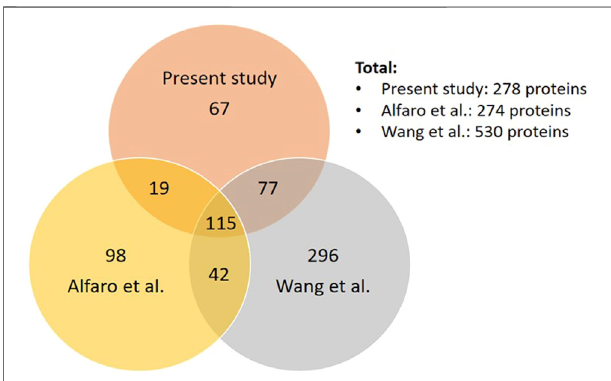
FIGURE 3 | Comparison of our dataset to the two most extensive datasets of cortical O-GlcNAcome. Venn diagram showing the number of proteins that are unique or common among our current datasets, Alfaro et al. (Alfaro et al., 2012) and Wang et al. (Wang et al.,